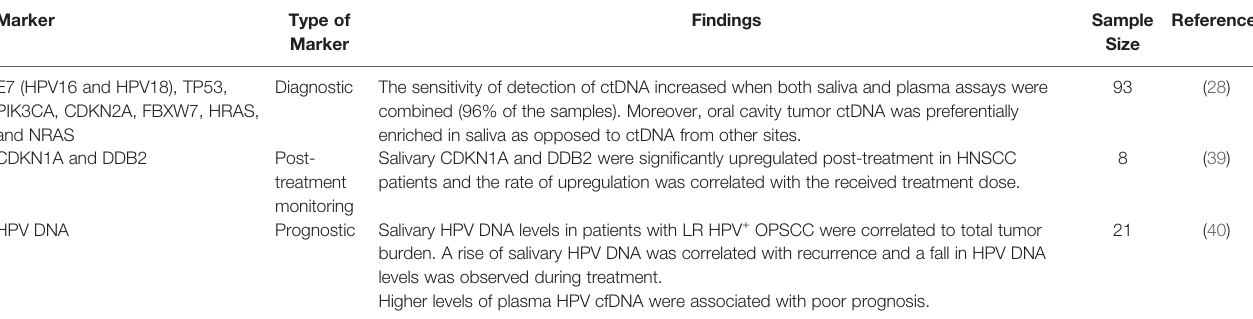
TABLE 1 | ctDNA biomarkers for